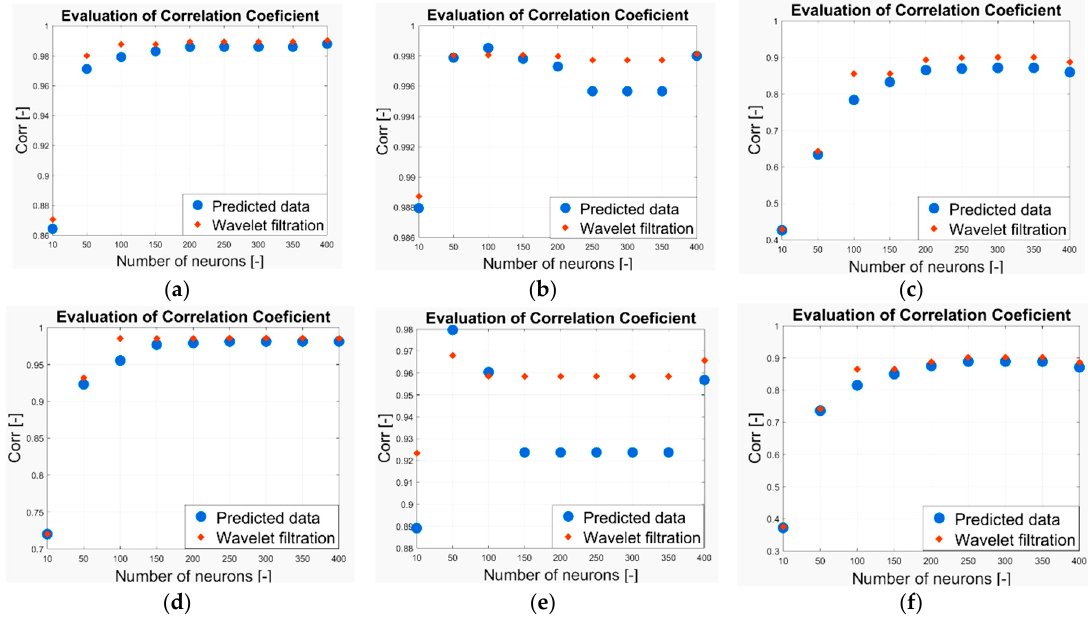
Figure 25. The correlation coefficient evaluation for the CO 2 prediction ( a ) 6–13 May 2018, ( b ) 15 May 2018, ( c ) 1–29 May 2018, ( d ) 6–13 November 2018, ( e ) 15 November 2018, ( f ) 4 November–3 December 2018.